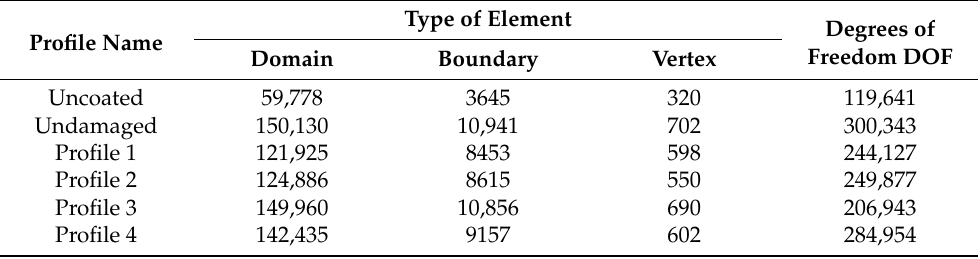
Table 6. Element’s properties.